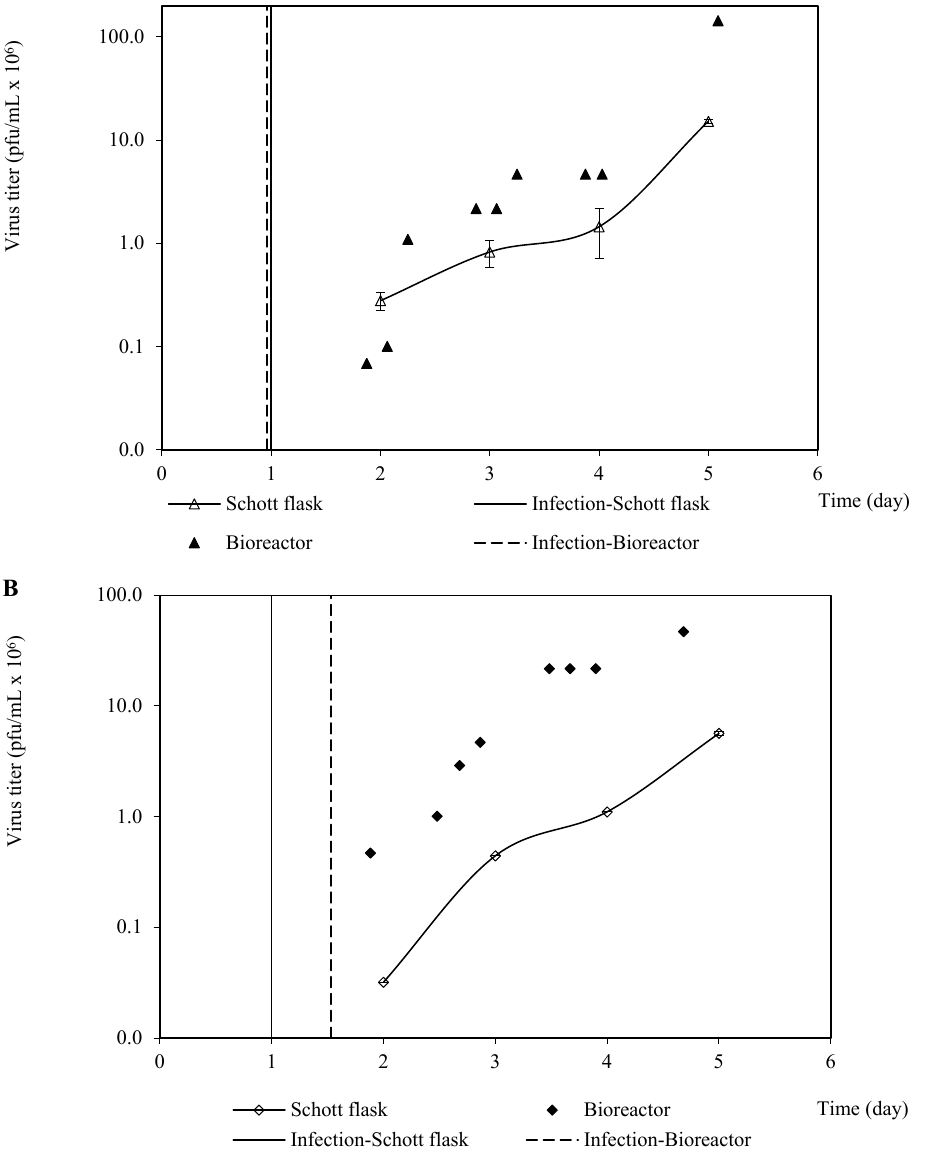
Figure 4. Kinetics of recombinant baculovirus production (pfu/cell) in Schott flask and bioreactor. ( A ) Kinetic production patterns of recombinant baculovirus carrying the rabies G glycoprotein. ( B ) Kinetic production patterns of recombinant baculovirus carrying the rabies M protein.